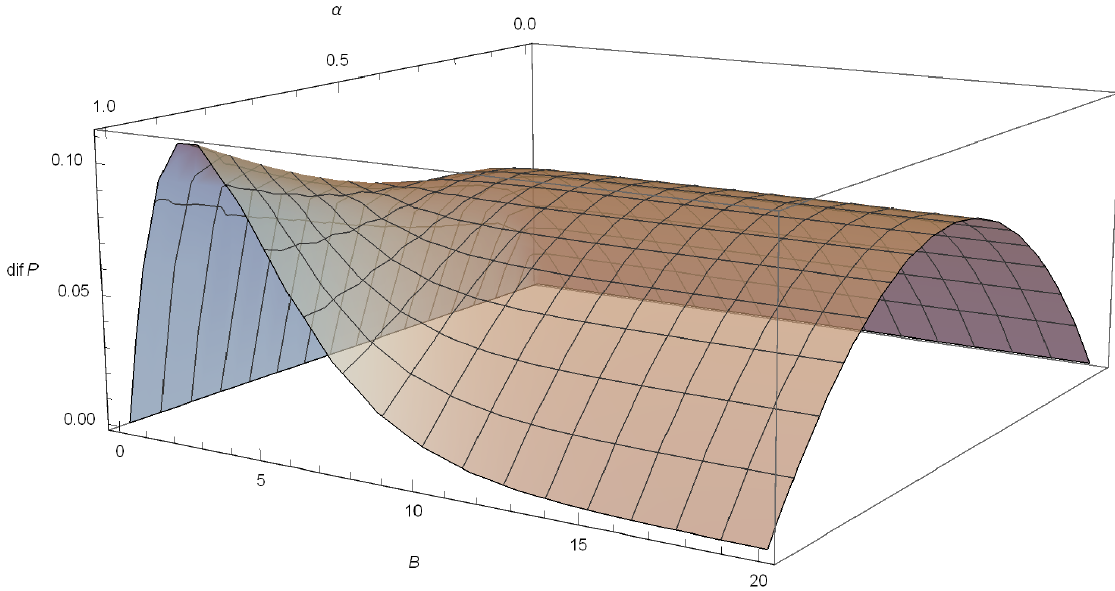
Fig 2. dif ( F ) in the Poisson-exponential case with δ = 0.03, λ = 1, γ = 0.6.